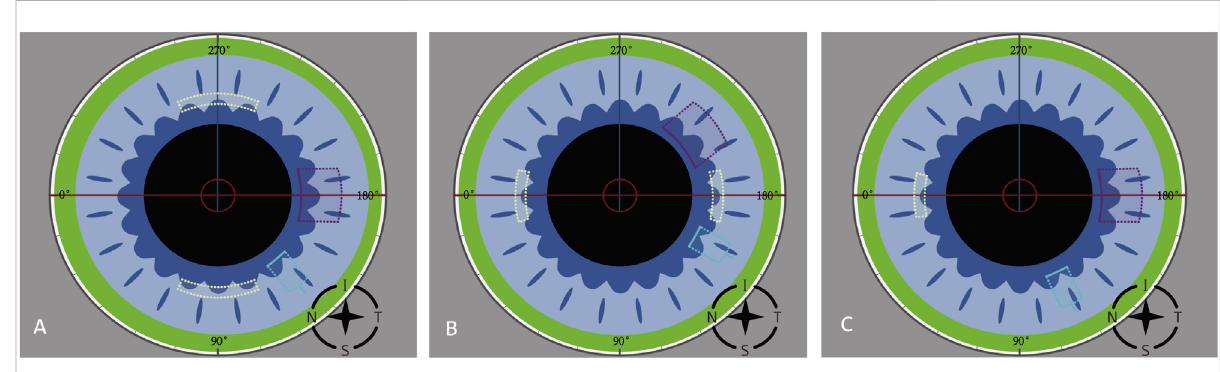
FIGURE 1 The animations from the FEMTO LDV Z8 program demonstrate the position of clear corneal incision (purple dots), paired arcuate keratotomy (yellow dots), and paracentesis (light blue dots) of FLACS with FSAK on the right eye.